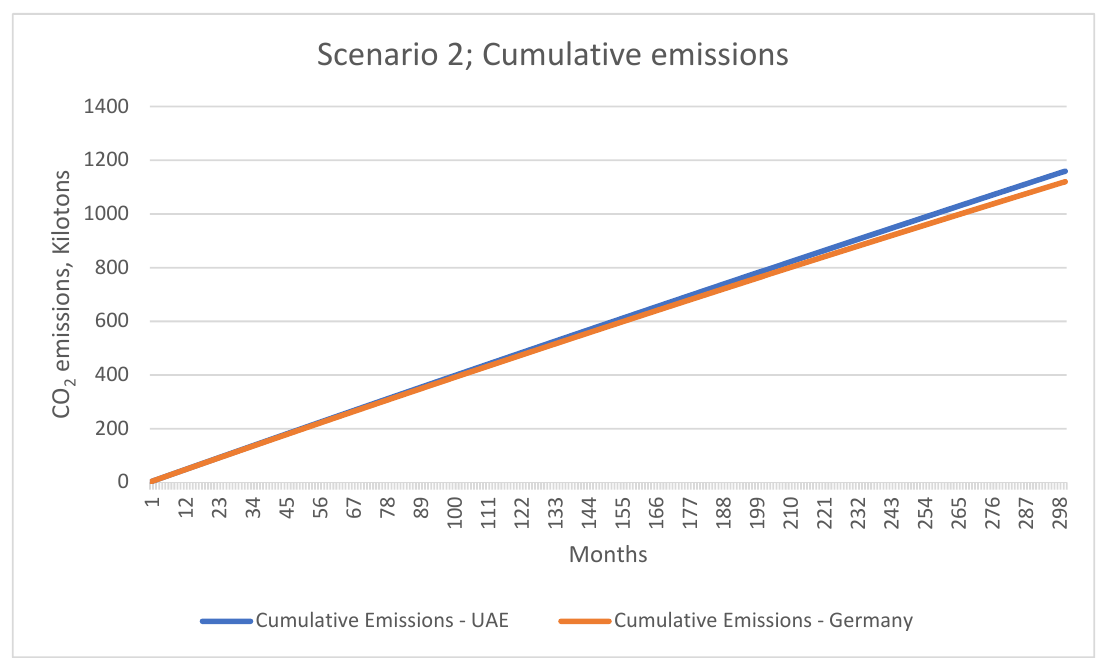
Figure 8. Cumulative expenditure through electricity consumption for UAE and DE under scenario 1.